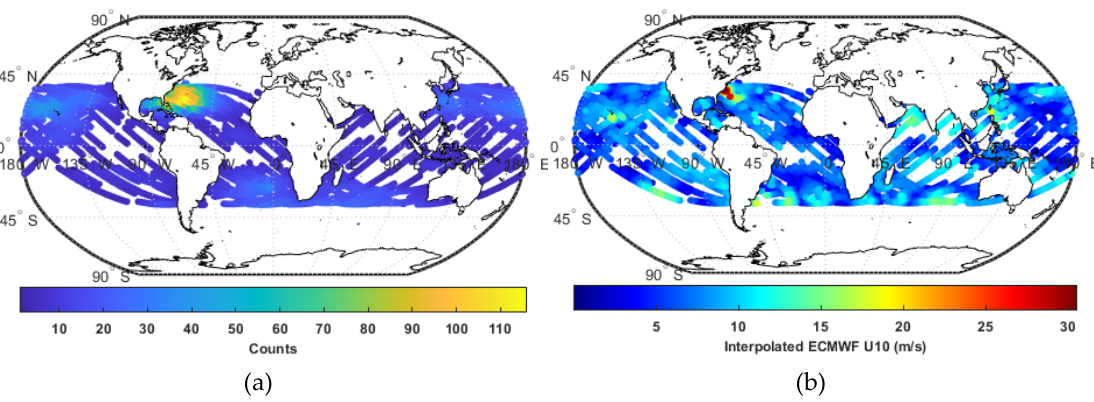
Figure 3. Geographical distribution of collected CYGNSS FR-DDM data in 2018 and corresponding interpolated European Centre for Medium-Range Weather Forecasts (ECMWF) 10-m-referenced ocean surface wind speed. ( a ) The color at the left part of the figure indicates the count per point. ( b ) The color at the right part of the figure indicates the coincident wind speed obtained by interpolating the ECMWF data.